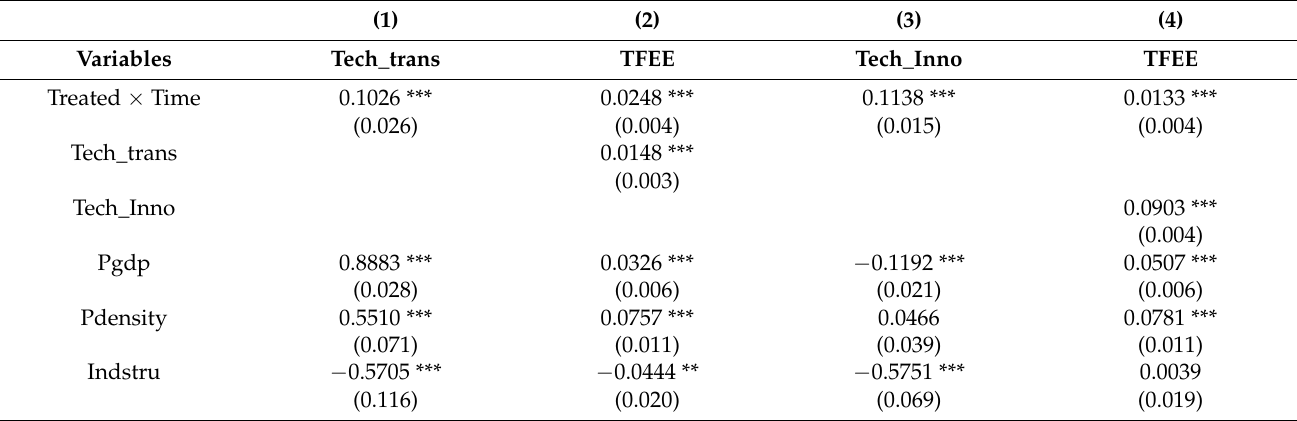
Table 9. Mediating effect test: technological transformation and technological